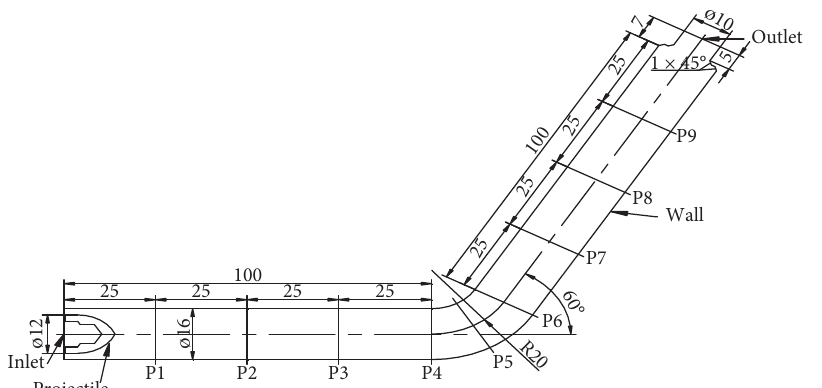
Figure 1: CFD model of a pipe with straight and curved segments for the simulations. All dimensions are in millimeters (no projectile for WAIM process).